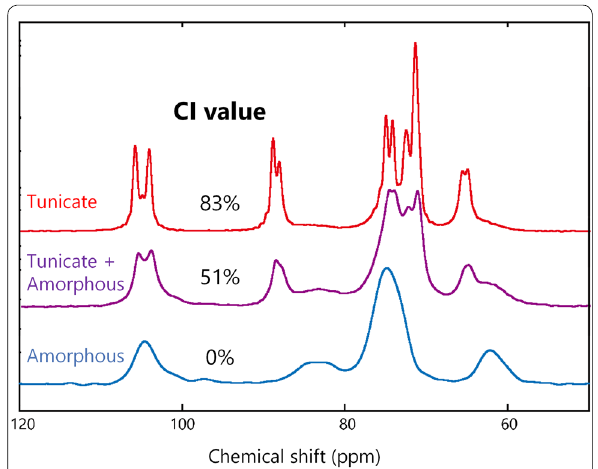
Fig. 2 NMR spectra of tunicate cellulose, a mixture of the tunicate and amorphous celluloses, and amorphous cellulose at 2 ms CT. The mass ratio of the tunicate cellulose in the mixture was